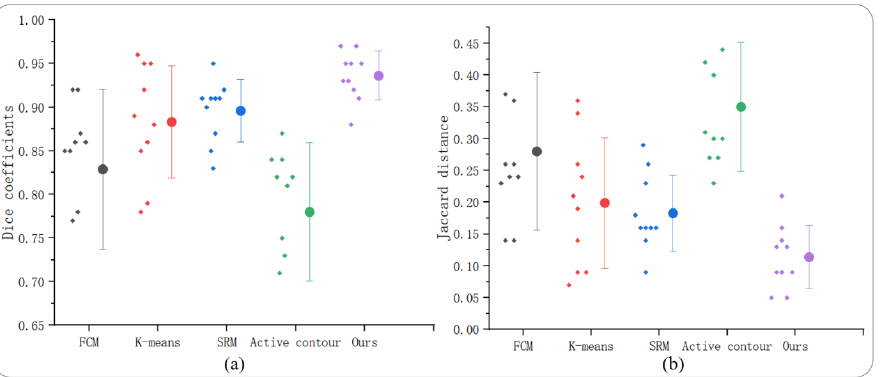
Figure 6. In the LIDC-IDRI dataset, the segmentation performance of our proposed method and the other four methods, ( a ) average dice coefficient, ( b ) average Jaccard distance. Figure 7 shows all the used image segmentation results obtained with our proposed method.